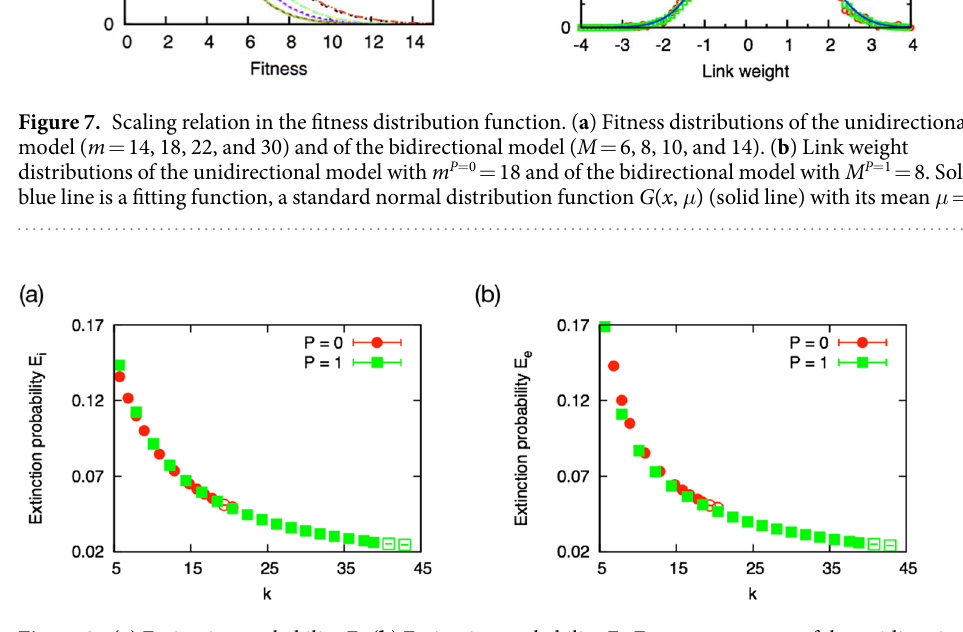
Figure 8. ( a ) Extinction probability E i . ( b ) Extinction probability E e . Emergent systems of the unidirectional and bidirectional models with same average unidirectional link degree show the same extinction probability against the direct disturbance event from the new species, E i . On the other hand, the extinction probability against the loss of a link, E e , is slightly smaller for the bidirectional model than that of the unidirectional